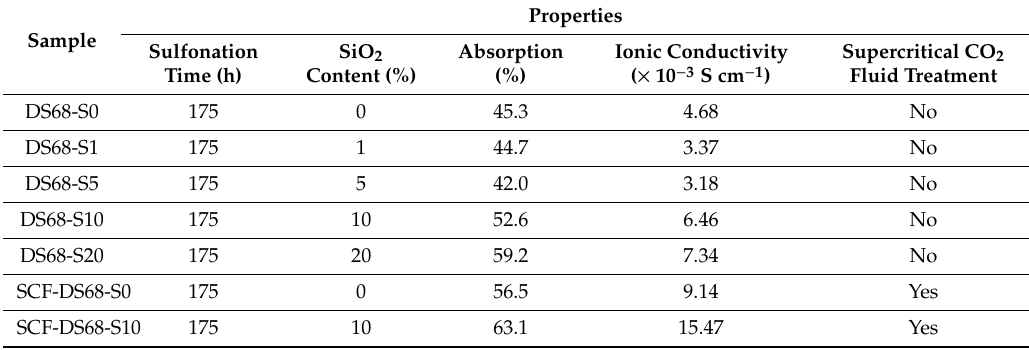
Table 2. E ff ects of nano SiO 2 blend ratio and supercritical CO 2 fluid treatment on the 68% degree of sulfonation (DS68) sPEEK composite electrolyte